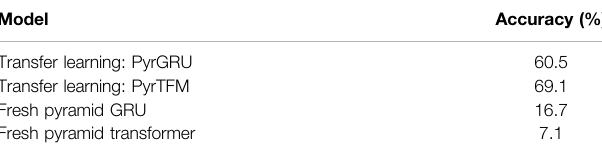
TABLE 6 | Comparison of the result of transfer learning on error type classi fi cation task. The models without transfer learning demonstrate no predicting power and no improvement during course of